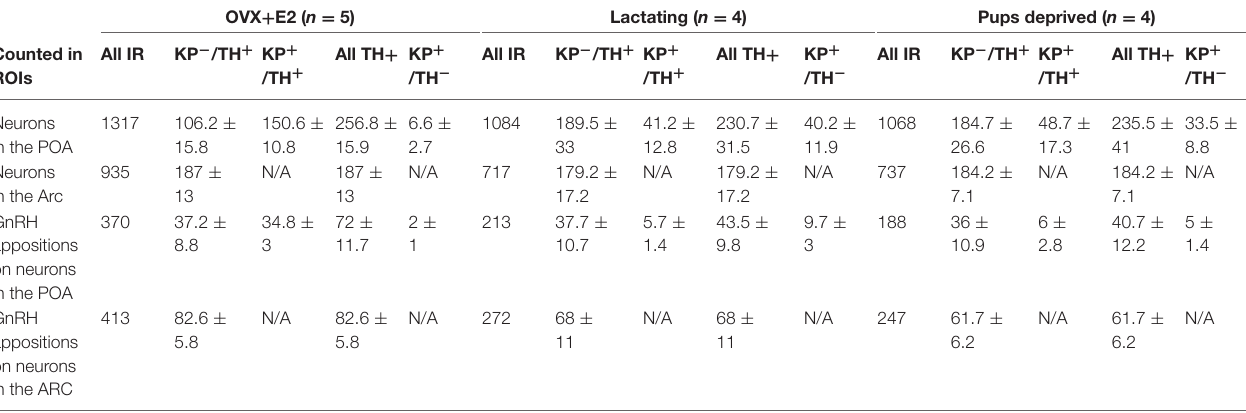
TABLE 1 | Number of neurons immunoreactive (IR) for tyrosine hydroxylase (TH) and/or kisspeptin (KP) in the preoptic area (POA) and gonadotropin releasing hormone (GnRH)-IR afferents on TH- and KP-IR neurons in the POA and on TH-IR neurons of the arcuate nucleus (Arc). OVX + E2 ( n = 5) Lactating ( n = 4) Pups deprived ( n = 4)